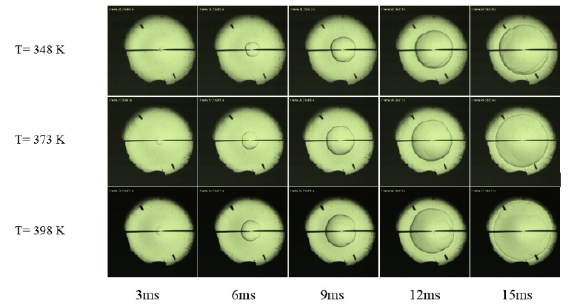
Figure 5. Comparison of experimental data for S u of methane at standard conditions with the published results.